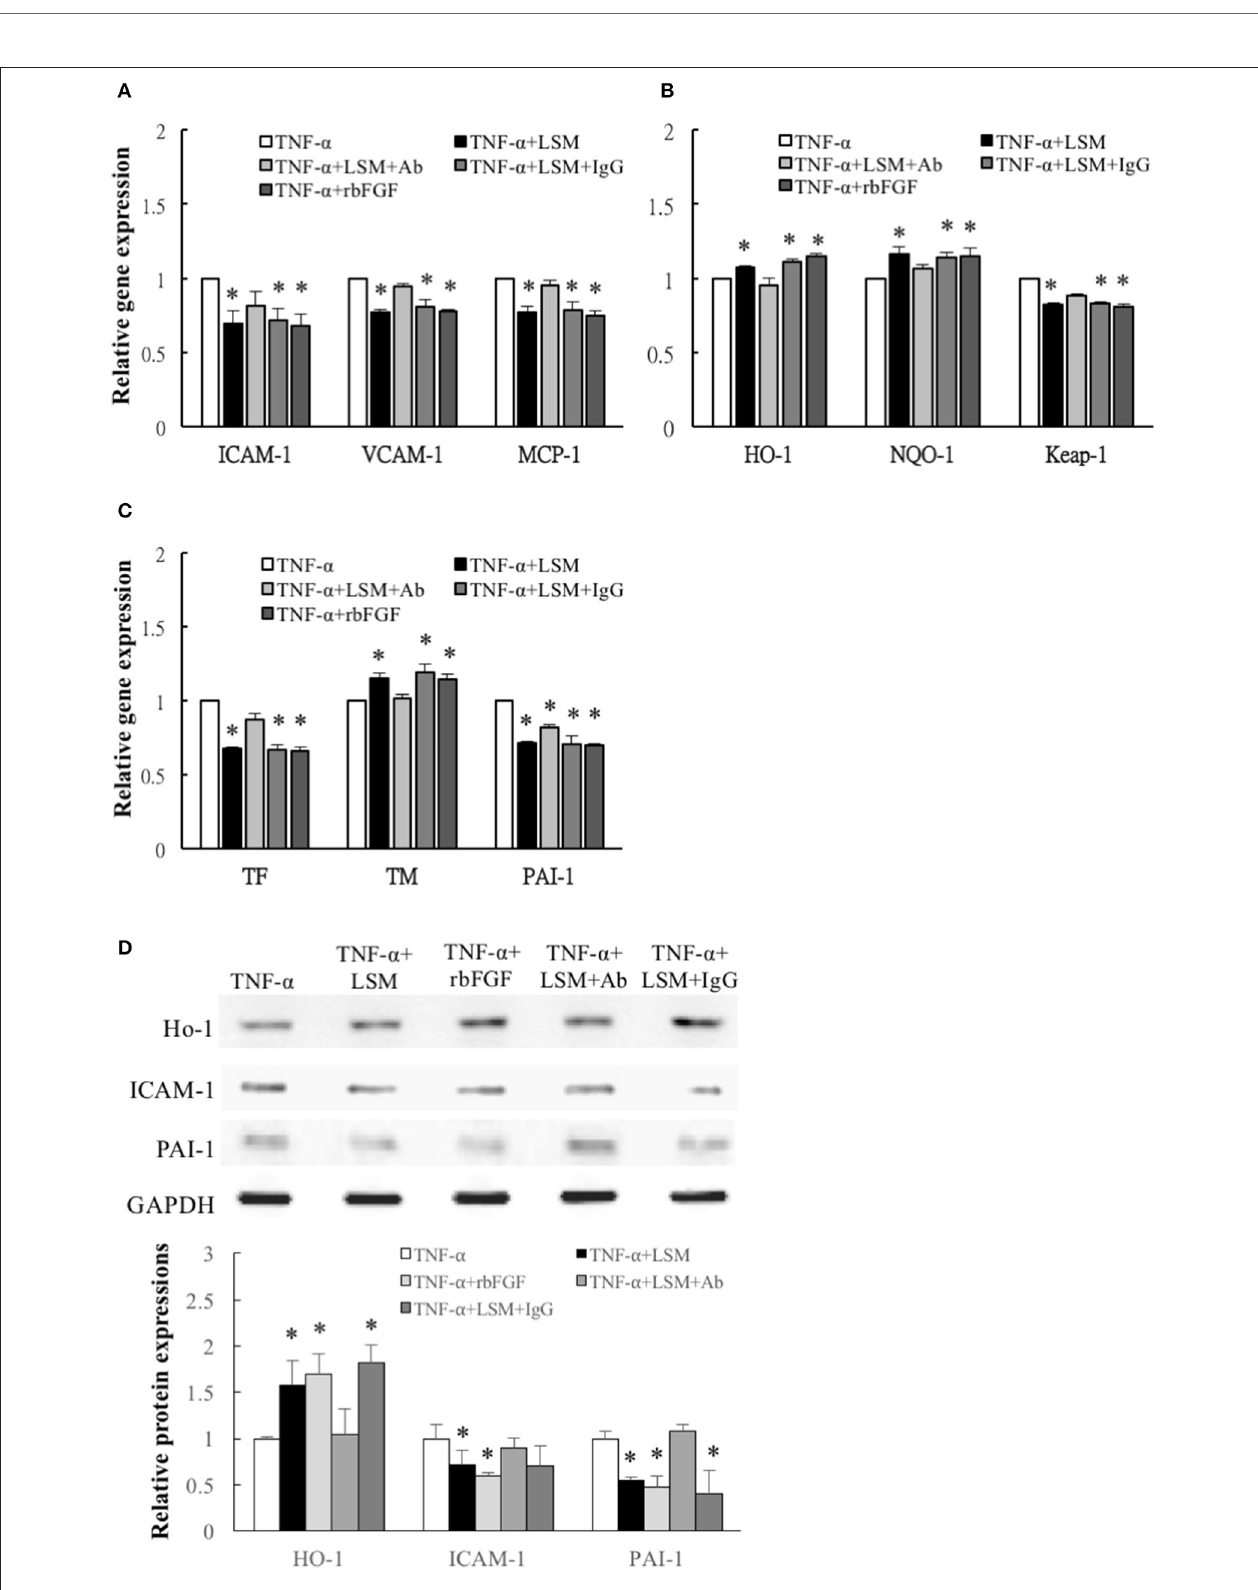
FIGURE 6 | Determination of inflammation, ROS induction, and thrombosis-related gene and protein expression. (A) Inflammation related ICAM-1 , VCAM-1 , and MCP-1 genes, (B) ROS induction related Keap-1 genes, and (C) thrombosis-related TF and PAI-1 genes were attenuated significantly in the TNF- α + LSM, TNF- α + LSM + IgG, and TNF- α + rbFGF groups compared to in the TNF- α groups. Significant attenuation of ICAM-1 , VCAM-1 , MCP-1 , TF , and Keap-1 were not